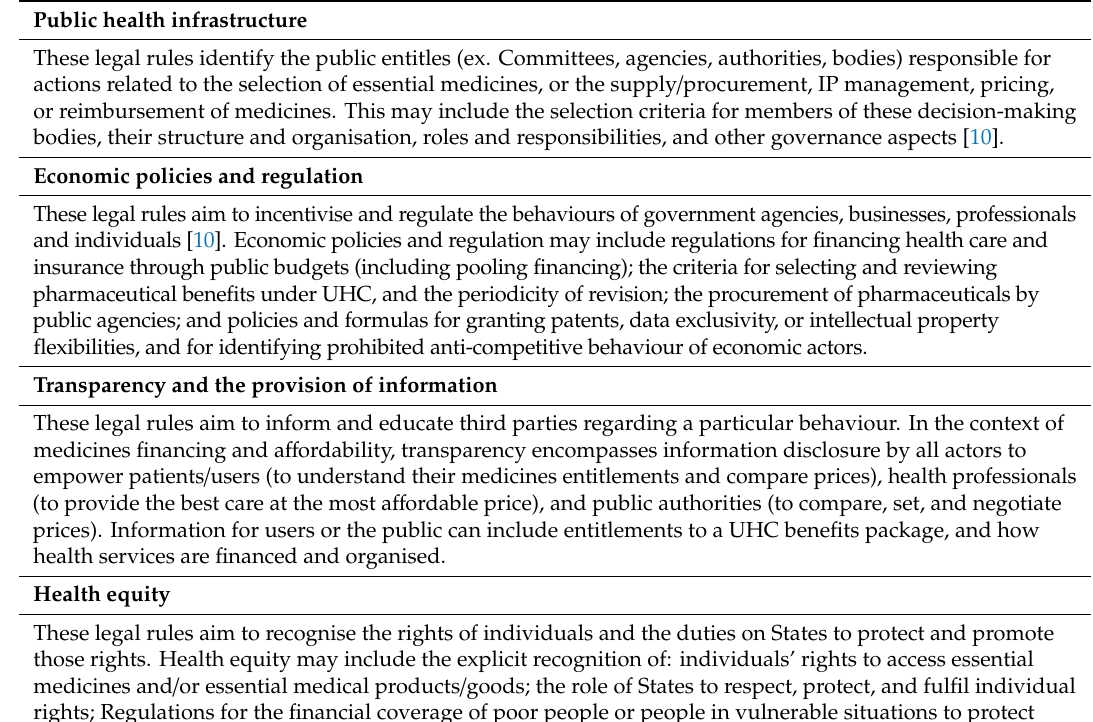
Table 2. Five objectives of public health law (modified from Magnusson et al. [10]) in relation to medicines a ff ordability and financing. Legend: * Economic operators are defined as business entities including but not limited to pharmaceutical manufacturers, distributors, importers, and